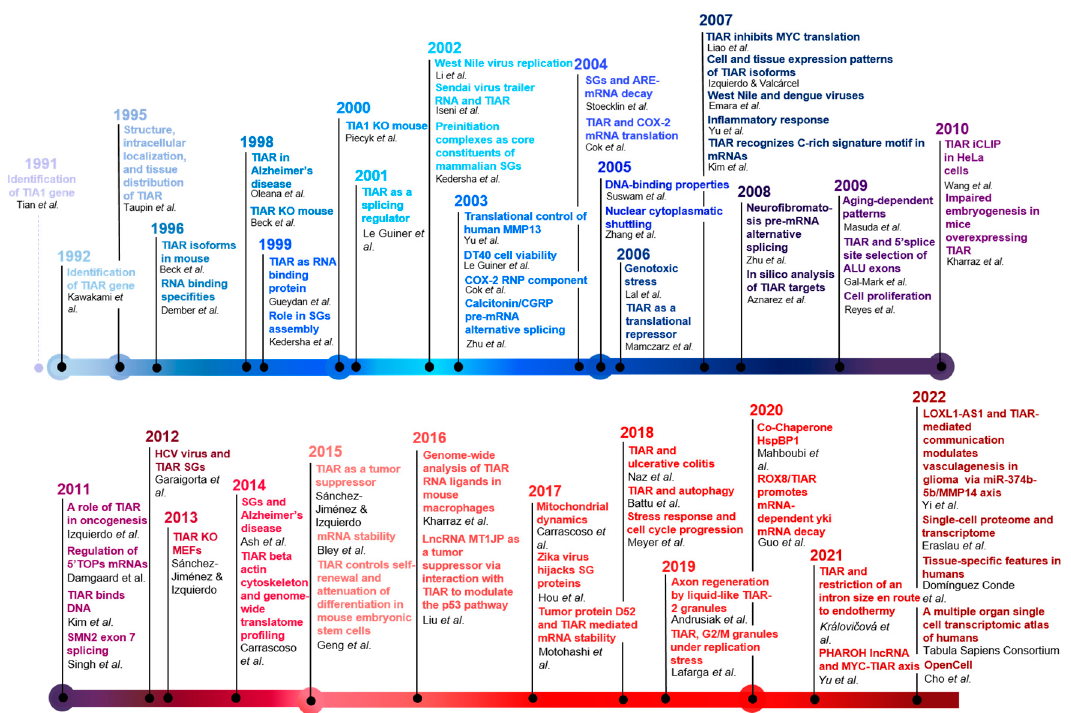
Figure 6. Breakthroughs of the TIAR timeline. To build this figure, we utilized the following refer- ences: [1–4,7,12–14,16–18,21,23,24,26,29,32–35,37–39,41,42,44–49,54–57,61,62,67–69,71,72,81–106].